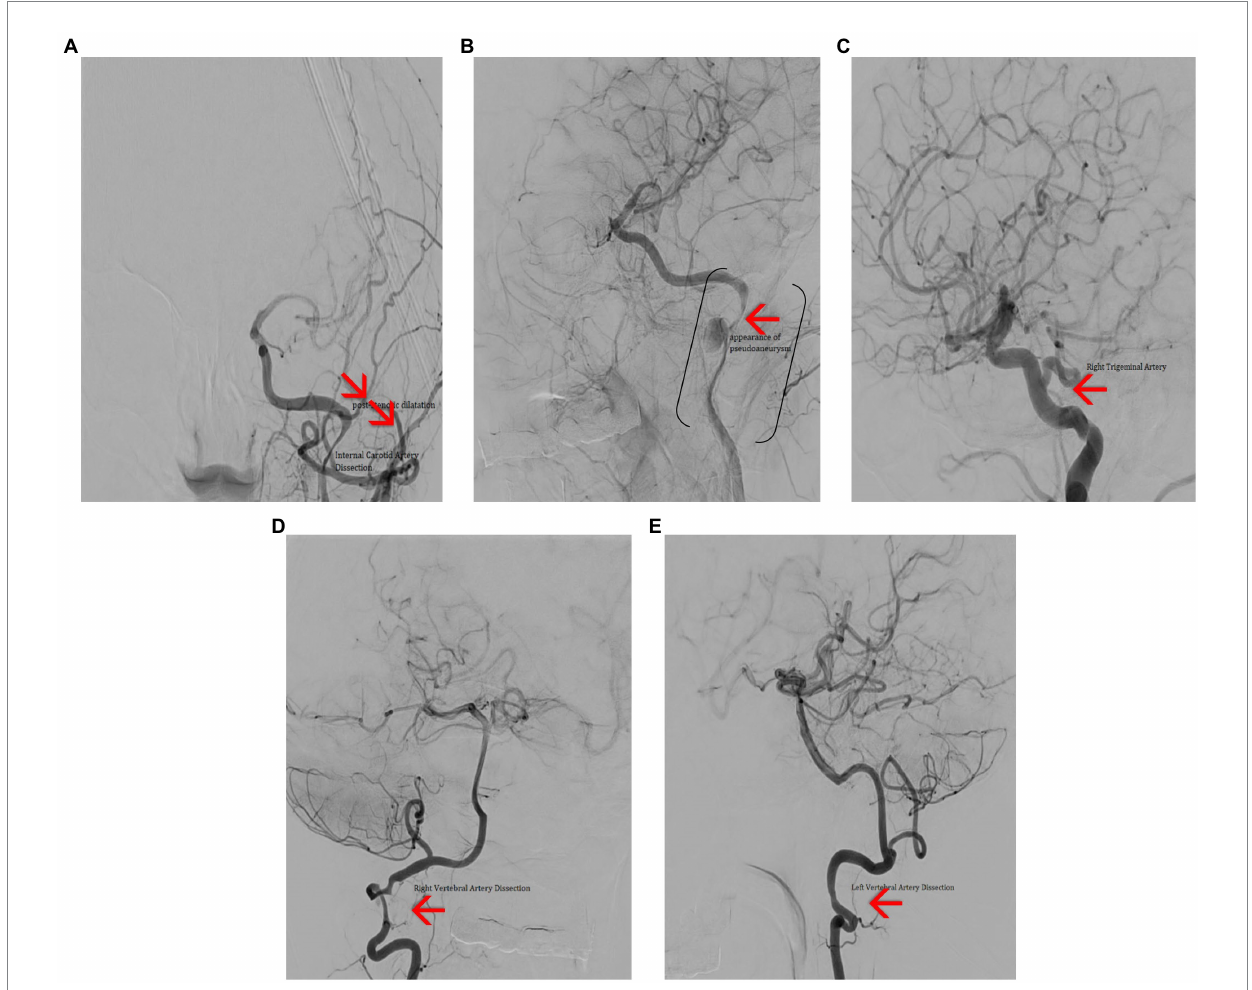
FIGURE 13 Cerebral angiography (A) – frontal view showing dissection in the C2–C3 segments of the left ICA, with post stenotic dilatation and poor intracranial filling. (B) Left anterior oblique view showing dissection of the C2–C3 segments of the ICA (brackets) and a pseudo-aneurism (red arrow). (C) Lateral view showing persistent right trigeminal artery (red arrow). (D) Frontal view showing right VA dissection (red arrow). (E) Lateral view showing left VA dissection (red